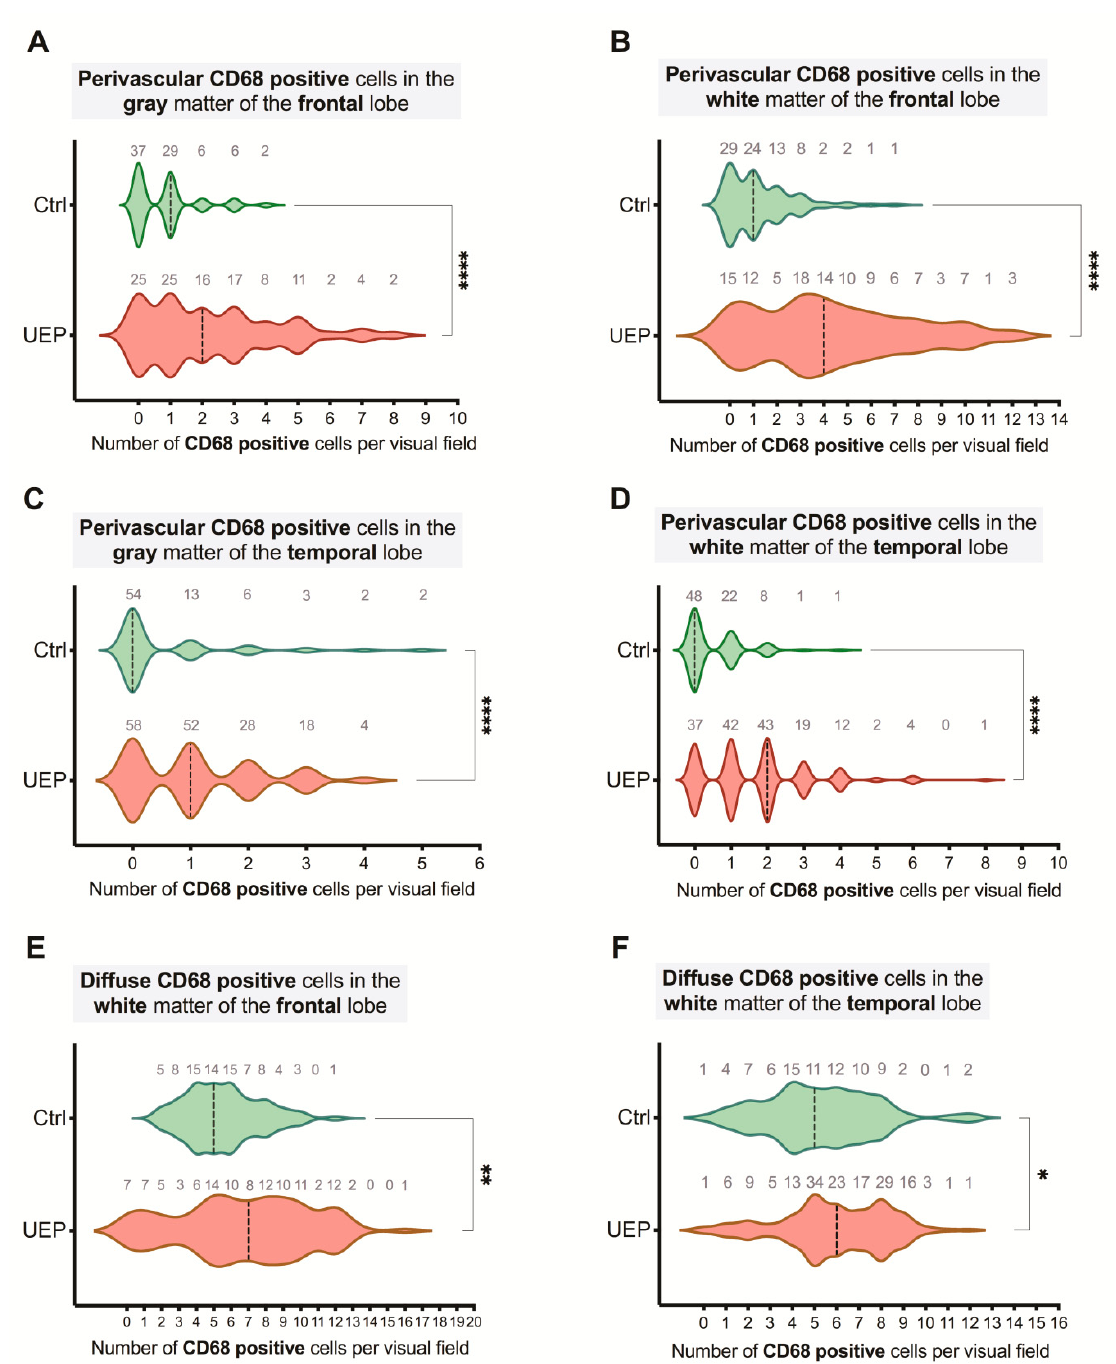
Figure 7. Violin plots representing the data of CD68 analysis: perivascular ( A – D ) and diffuse ( E , F ) distribution of CD68 positive cells per visual fields in the gray and white matter of the unspecified encephalopathy (UEP) group and controls (Ctrl) in the PCR+ brain samples, frontal lobe temporal lobe; violin plots: dashed lines represent the approximate ratio of respective visual fields with HHV positive cells to fields with HHV negative cells (“0”— ratio less than 1.0, “1”— more than 1.0); asterisks represent a significance level (* p < 0.05; ** p < 0.01; **** p < 0.0001; Mann-Whitney U-test).